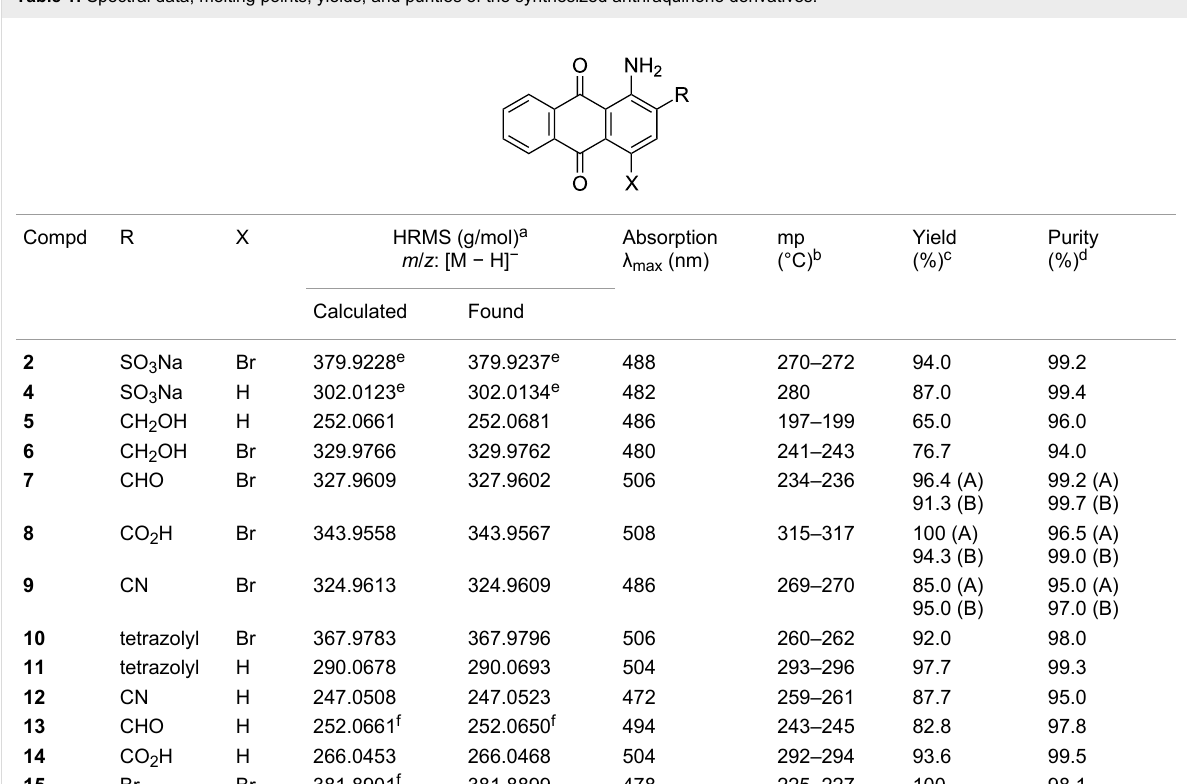
Table 1: Spectral data, melting points, yields, and purities of the synthesized anthraquinone derivatives.